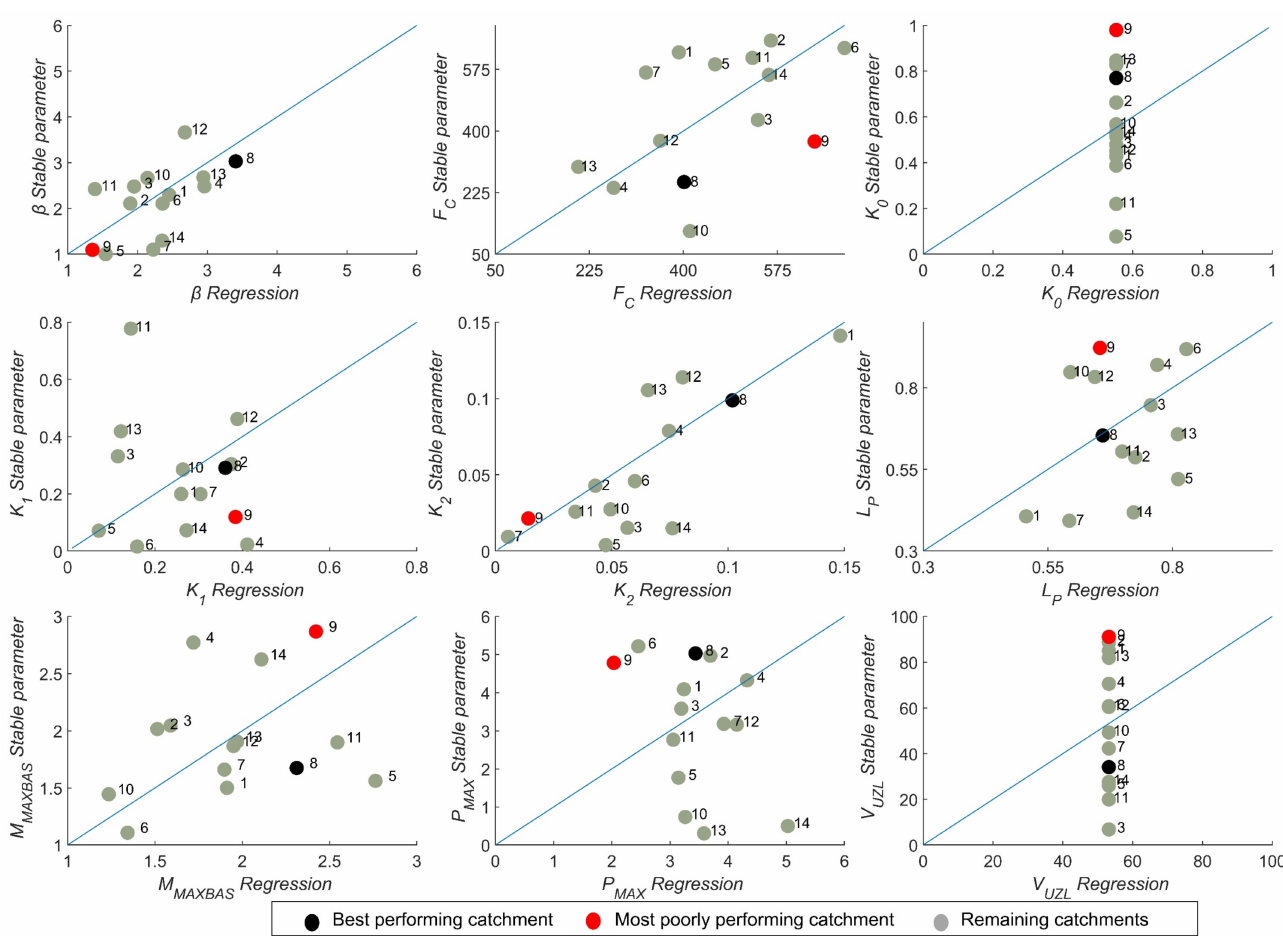
Figure 6. Relationships between best parameters estimated from stable sets and parameters derived from the regression model. The black scatters (catchment #8) represent the catchment with most parameters that are highly identified during parameter estimation and its corresponding parameters during regression. The red scatters (catchment #9) represent a catchment with most parameters that are poorly identified during parameter estimation and its corresponding parameters during regression. For unidentifiable parameters ( K 0 and V UZL ), their median value was taken for the regionalized